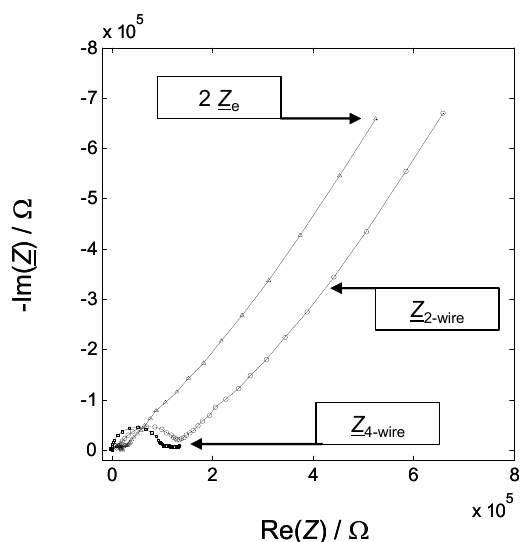
Figure 6. Impedance spectra (Nyquist Plots) of a two-wire (B – C) and a four-wire measurement and the calculated electrode impedance 2 × Z